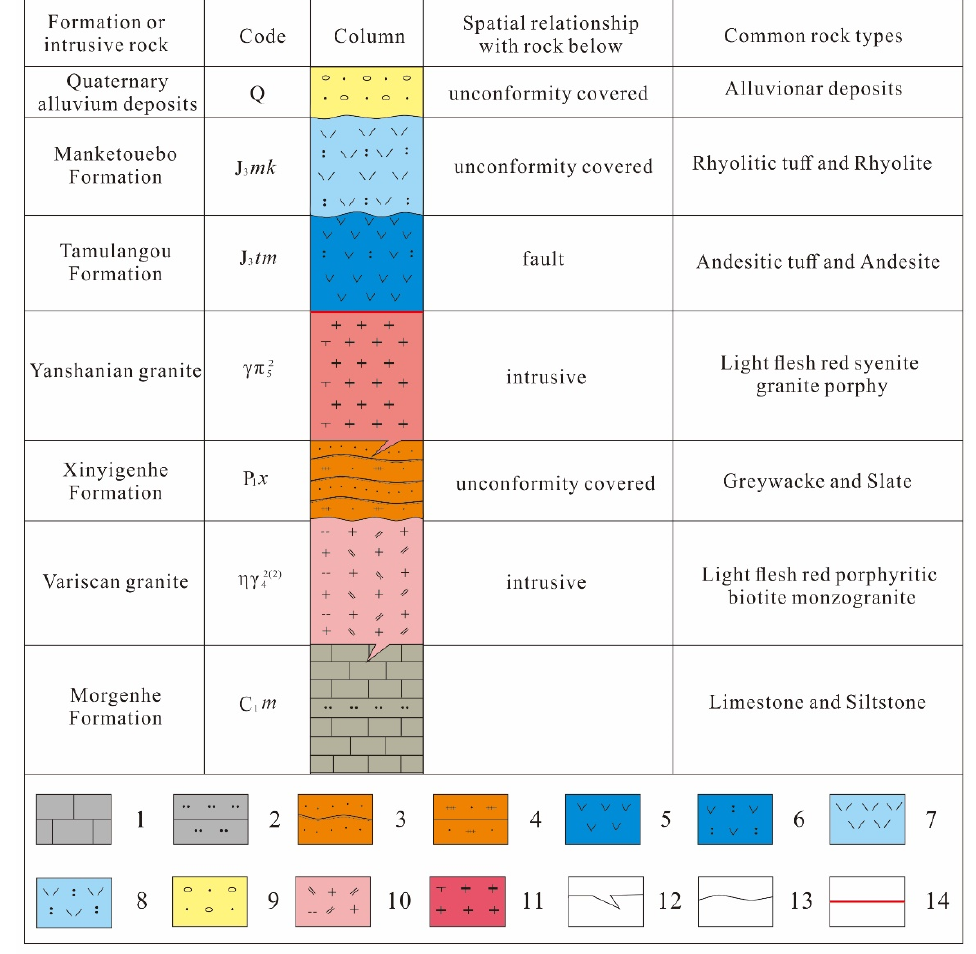
Figure 2. Common rock combinations of each formation around the Qiyimuchang deposit. 1—Limestone; 2—Siltstone; 3—Slate; 4—Greywacke; 5—Andesite; 6—Andesitic tuff; 7—Rhyolite; 8—Rhyolitic tuff; 9—Alluvium deposits; 10—Variscan light flesh red porphyritic biotite monzogranite; 11—Yanshanian light flesh red syenite granite porphyry; 12—Intrusive; 13—Unconformity covered; 14 — Fault.